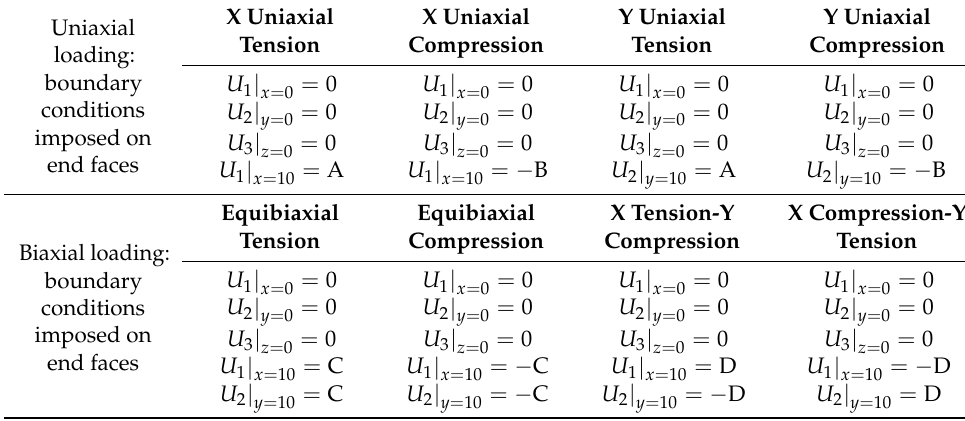
Table 2. Boundary conditions for uniaxial and biaxial loading (unit: mm).